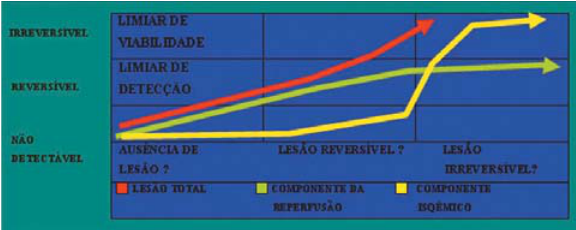
Fig. 1 - Comprometimento miocárdico evolutivo decorrente de isquemia, reperfusão ou obstrução